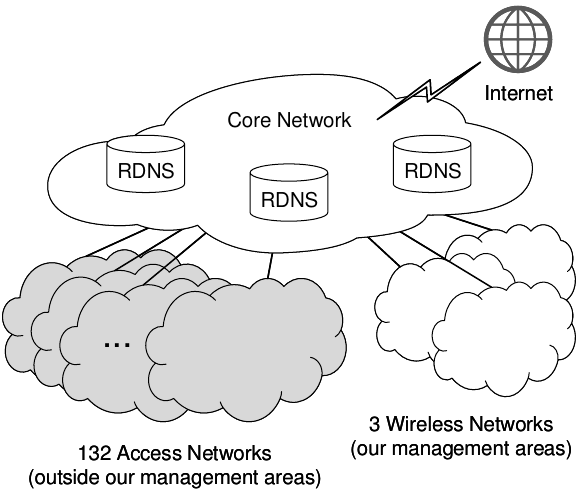
Figure 5. Layout of our campus